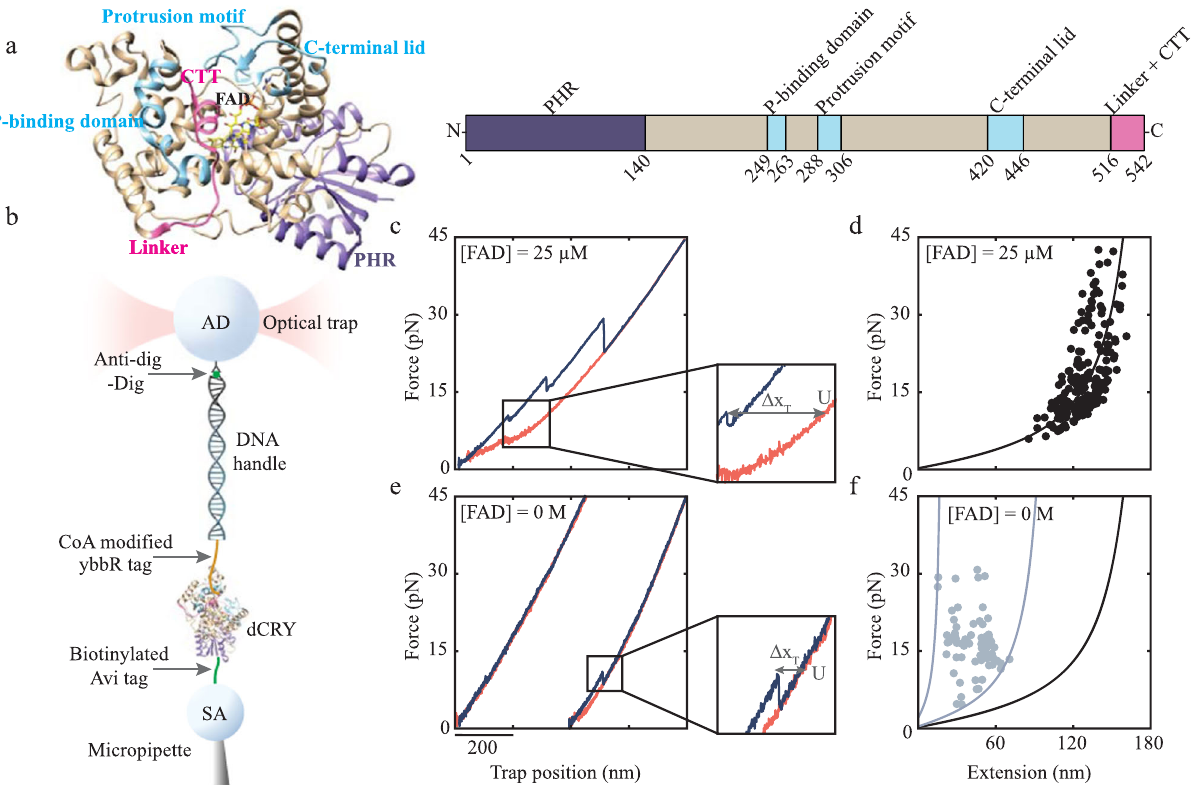
Fig. 1 | Experimental design to study dCRY folding with optical tweezers. a Structure of full-length dCRY (left) and domain organization (right) (PDB ID: 4GU5). b Schematic representation of the optical tweezers set up to mechanically manipulate a single dCRYmolecule between a streptavidin-coated bead (SA) and a bead coated with antibodies against antidigoxigenin (AD). c Force-extension tra- jectory of the mechanical unfolding (blue) and refolding (red) of dCRY in the presence of [FAD]=25 μ M. Indistinguishable results were obtained with and with- outMg 2+ at0.5mM.Zoomed-inisthetotalchangeinextension( Δ x T )measurement from the folded to the unfolded state. d Worm-like chain (WLC) analysis of Δ x T vs.